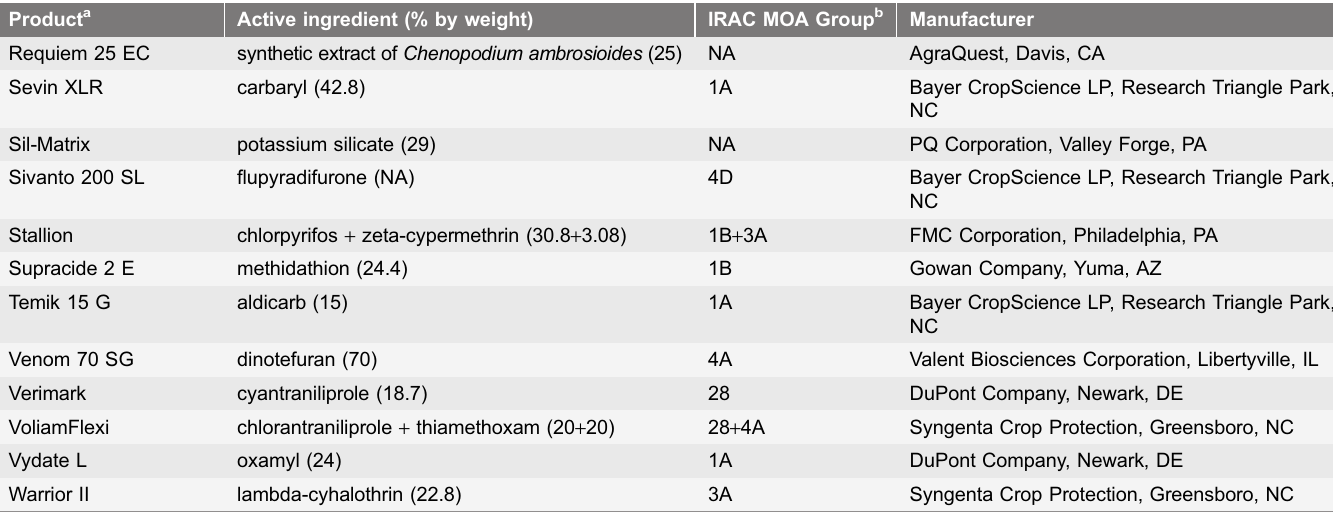
(HMO). Without adjuvant comparisons are presented for insecticides evaluated at the same rate (Table